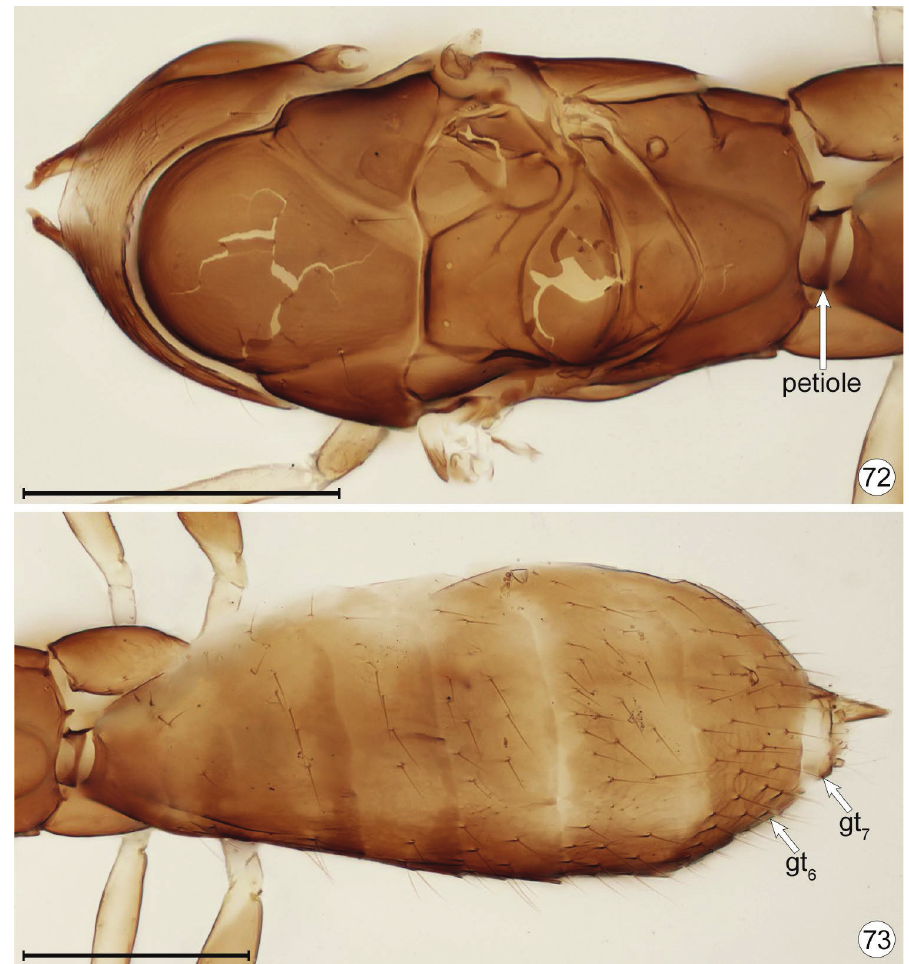
Figures 72, 73. Neotriadomerus burwelli , holotype. 72 mesosoma, dorsal 73 metasoma, dorsal. Scale bar = 300 μm. Neotriadomerus crassus Huber, sp. n. http://zoobank.org/DC4DB59A-207D-4DBD-9234-C944B9FD71AA